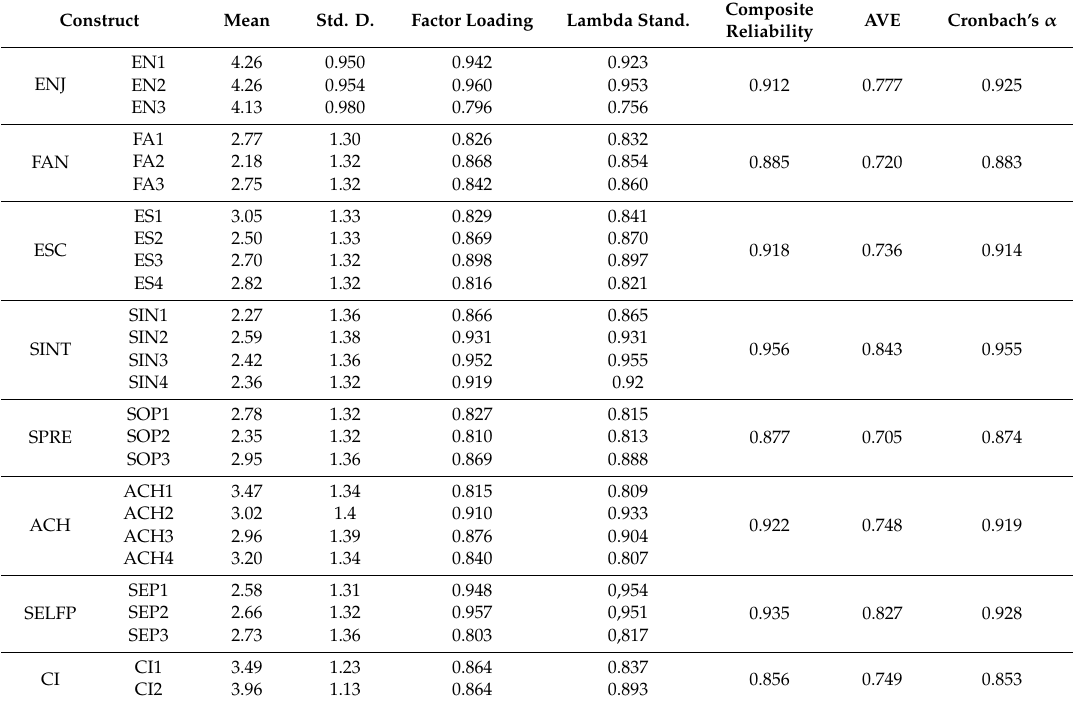
Table 2. Measurement scales.